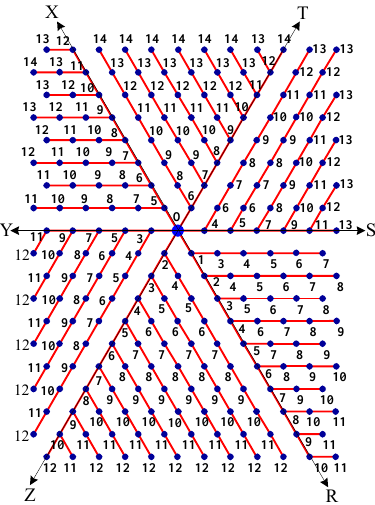
Figure 13. A node of label 5 means that the node receives the message from its neighbor at 5 th time